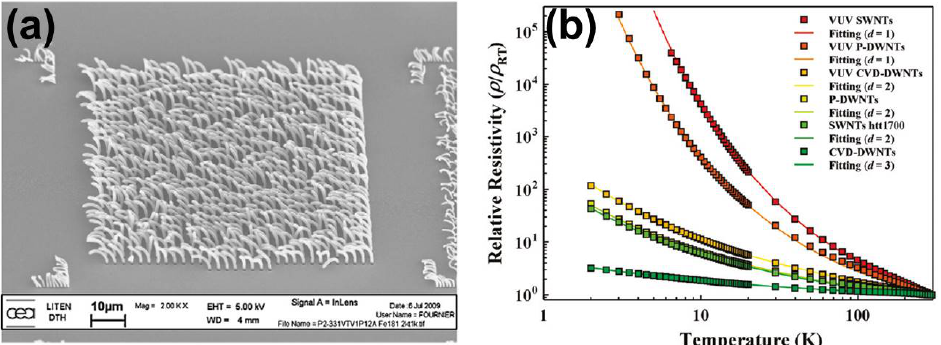
( a ) The selective growth of DWNTs and TWNTs is achieved on doped silicon via TiN structures in specific regions over the surface. ( b ) Relative resistance as a function of temperature for the SWNT, pea pod-derived and CVD-DWNT films before and after vacuum ultraviolet treatment. It is observed that the ultraviolet (UV) treatment largely increases the relative resistance of the films. Reproduced with permission from [158], Copyright American Chemical Society,